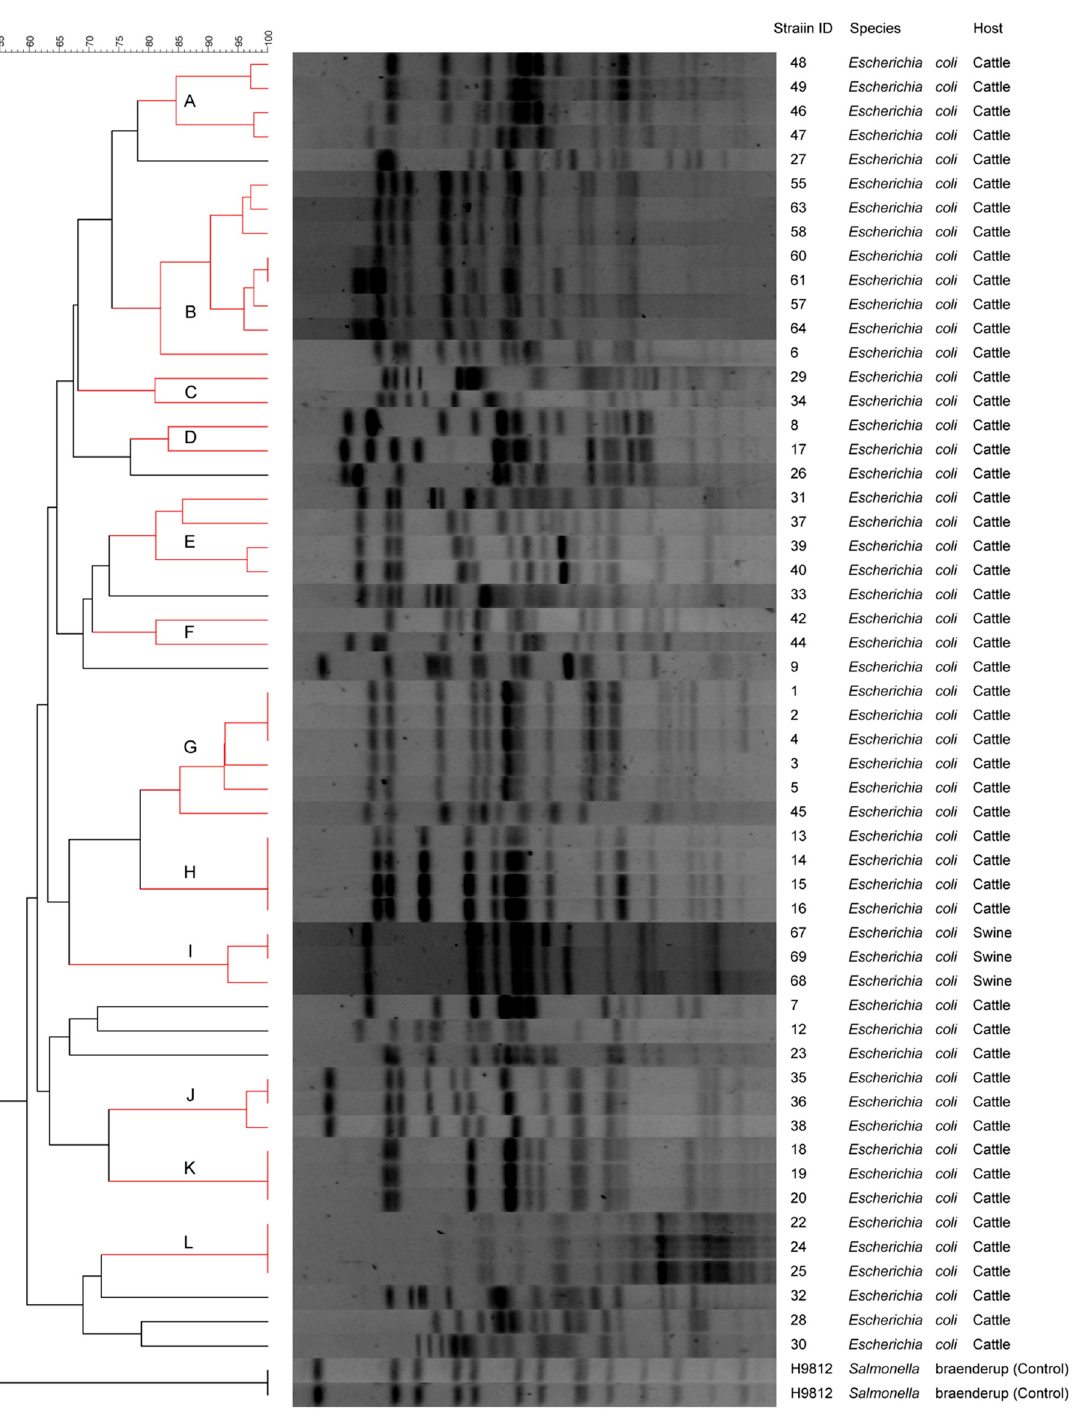
Figure 1. Dendrogram of 54 STEC strains isolated from cattle and swine using PFGE, showing the 12 clusters identified (A to L) in red.